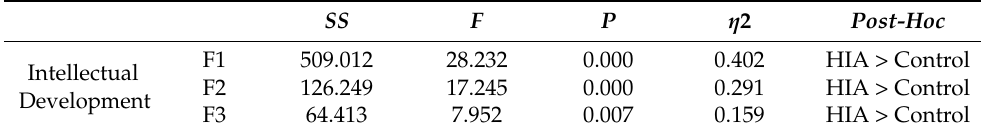
Table 5. Intergroup differences according to ethical sensitivity factors. SS F P η 2 Post-Hoc Intellectual